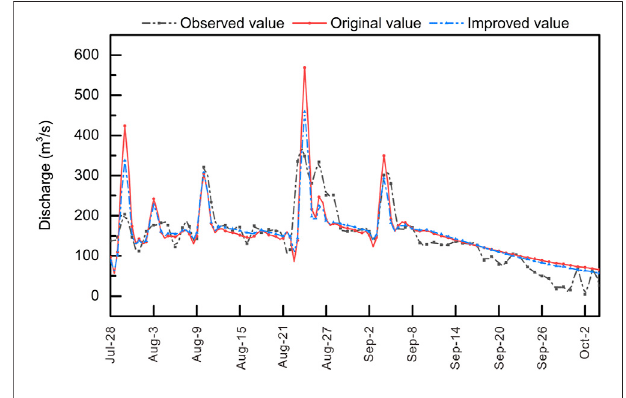
FIGURE 7 | Daily discharge during the fl ood season in the year 2015 before and after model